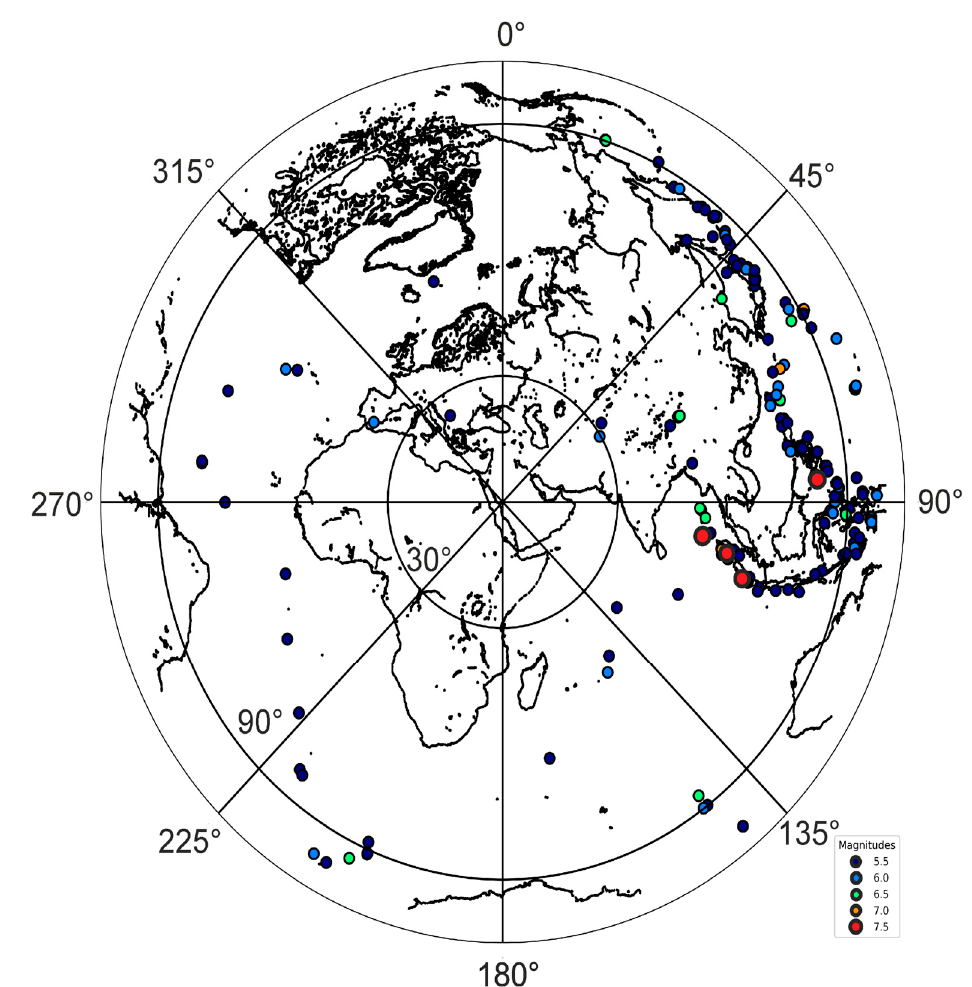
Figure 2. The distributions of earthquakes at teleseismic distances used in this study.